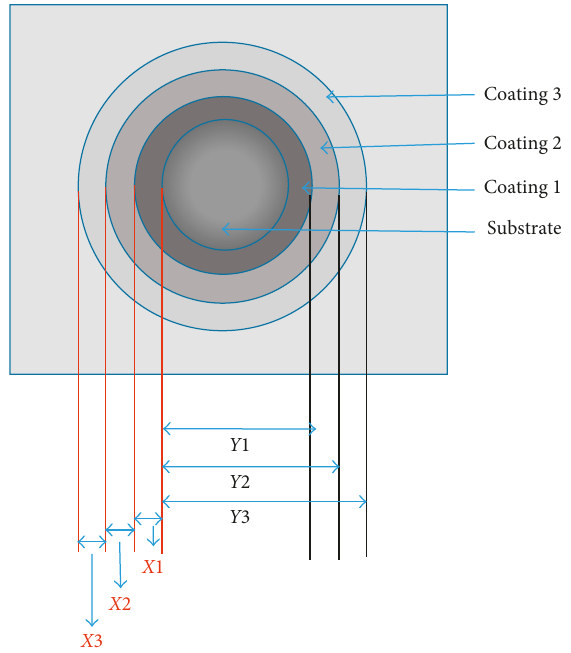
Figure 1: Schematic representation of ISO-26423:2009 to thickness determination for coating with multiple layers.